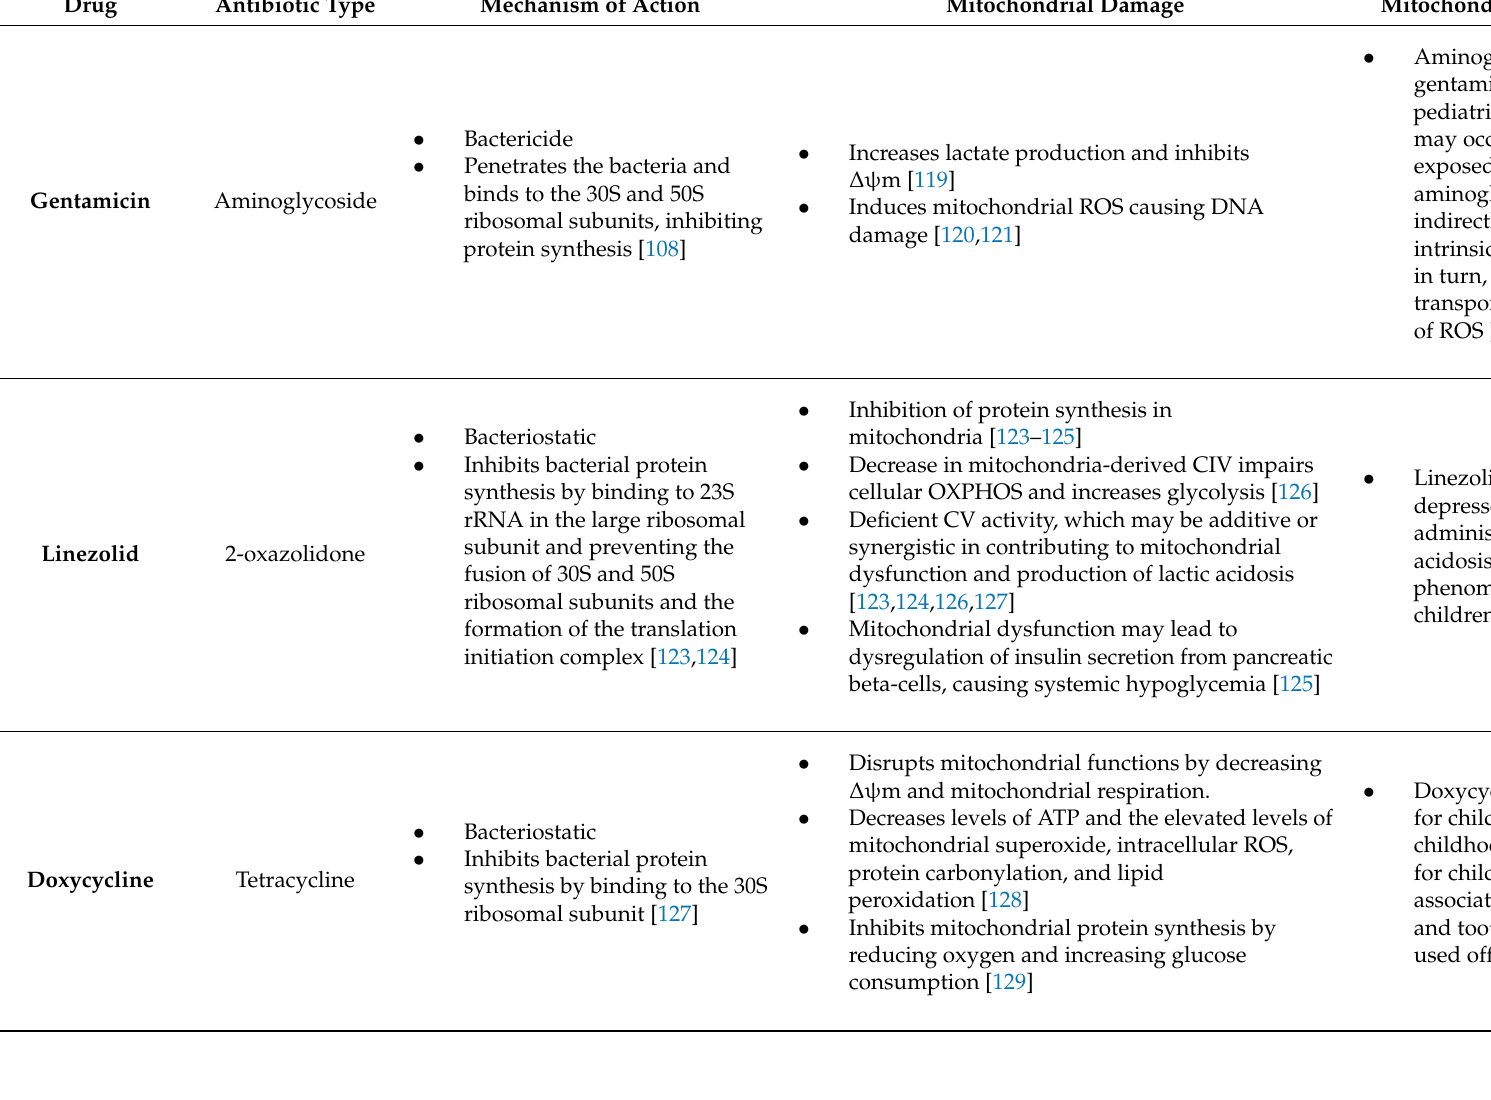
Table 4. Antibiotic therapy of S. aureus infection, mechanism of action, associated mitochondrial damage, and relevant pediatric studies.